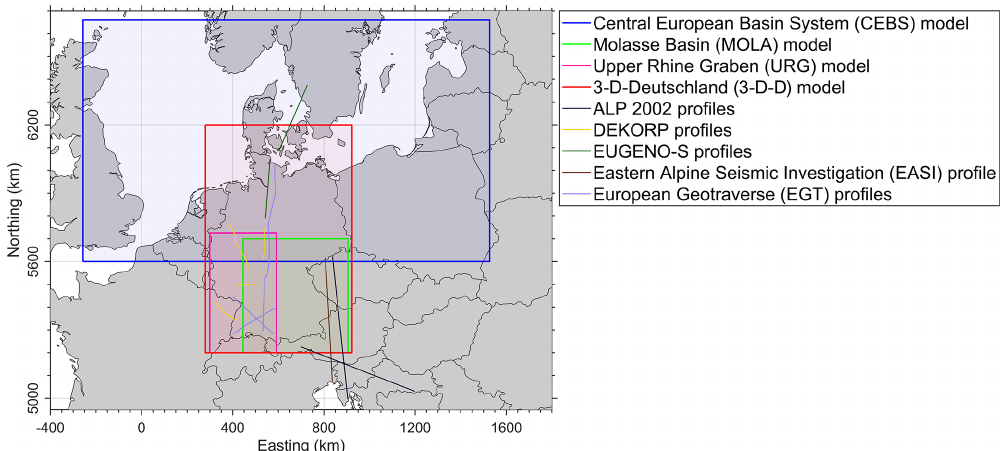
Figure 1. Geographical map of the regional model boundaries and seismic profiles used to solve discrepancies. The 3-D-D model area is shown in red and spans 1000km in North-South and 643km in East-West direction. Map coordinates in this and in all following figures are given inkm in UTM Zone 32N coordinate